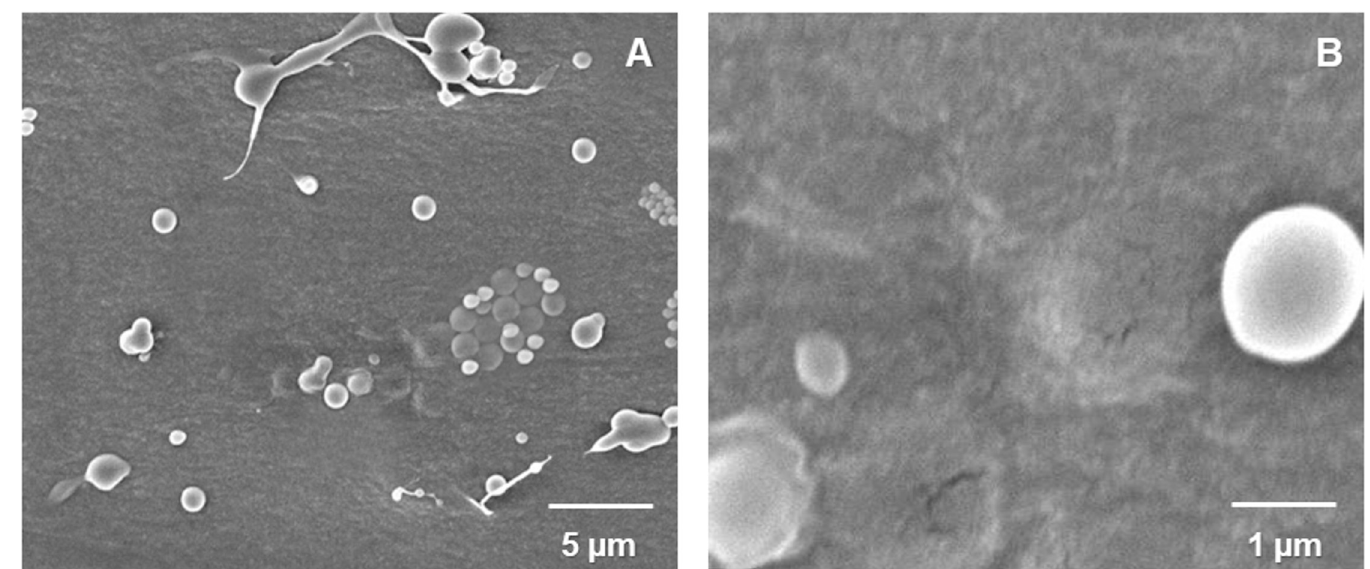
Fig 1. Micrographs of chitosan nanoparticles. Scanning electron microscopy (SEM) images at 5 kV of selenium-loaded chitosan nanoparticles at A) 3,000x and B) 10,000x magnification.